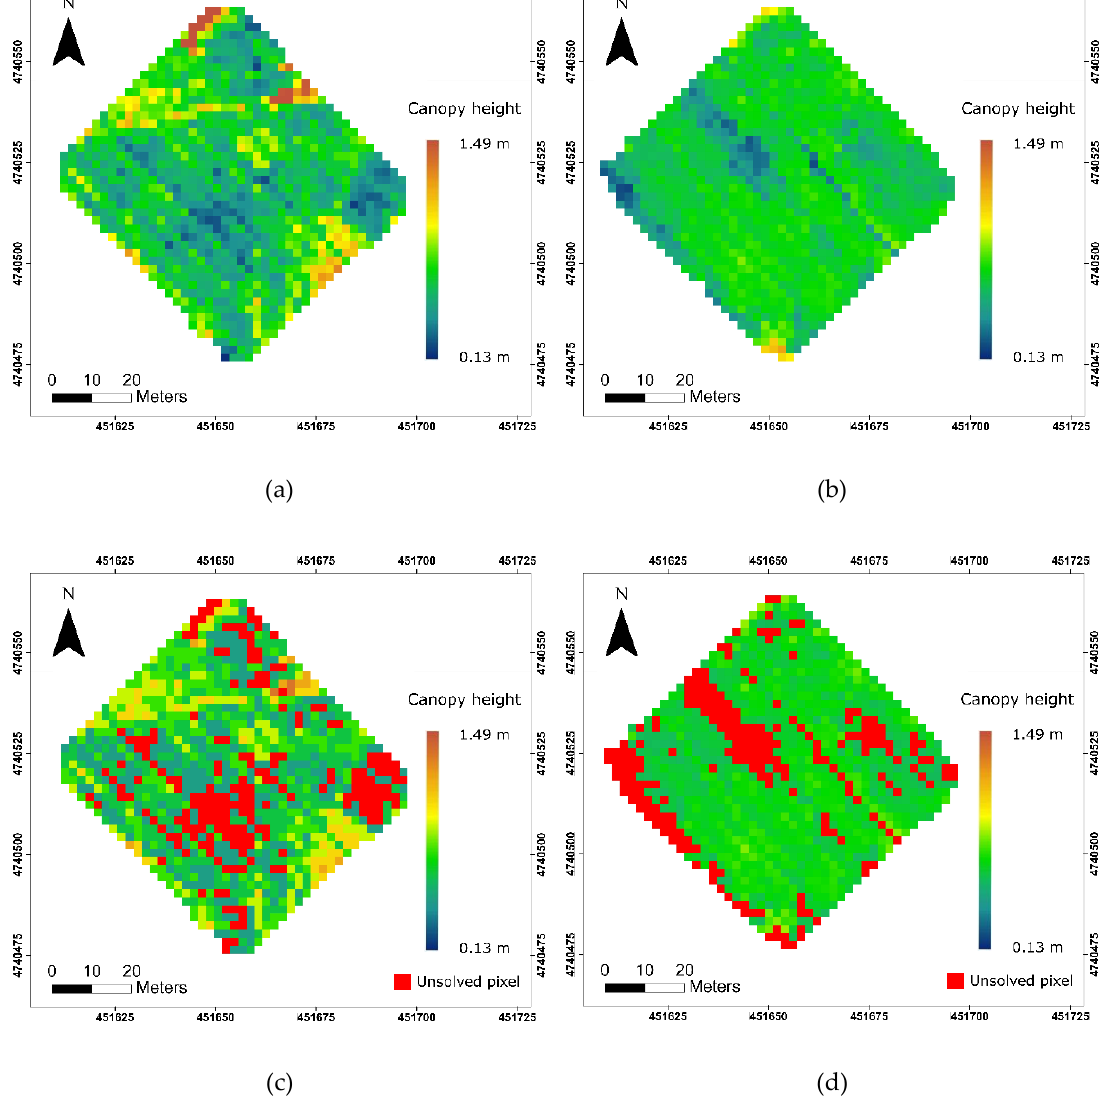
Figure 11. The winter wheat canopy height produced by Khanna’s method. ( a ) Canopy height map on 16 May. ( b ) Canopy height map on 31 May. ( c ) canopy height map with unsolved pixels on 16 May. ( d ) Canopy height map with unsolved pixels on 31 May.